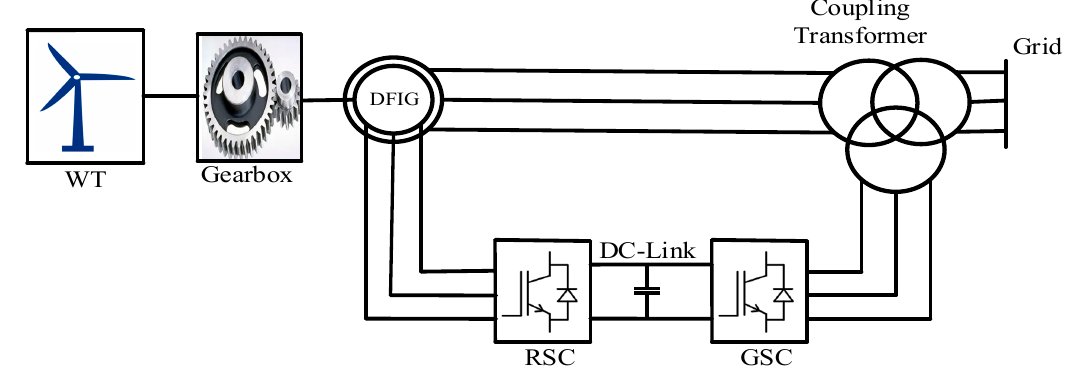
Figure 3. Schematic for DFIG-based WECS.